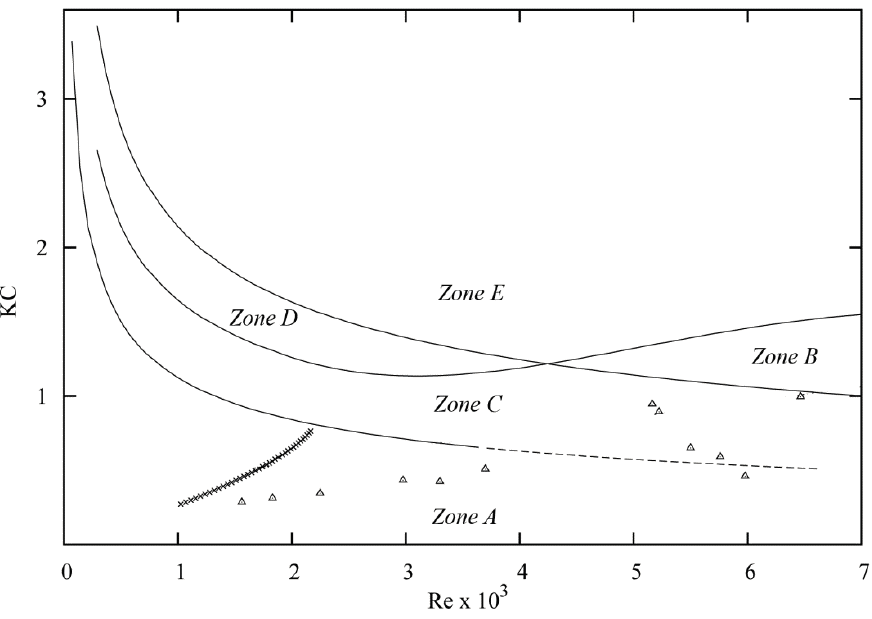
Figure 2. Scheme of viscous-fluid oscillatory-flow regimes in terms of KC and Re : (××) waves selected for a preliminary evaluation of the quantities defined in Equations (10), (11), (14) and (15); ( ∆∆ ) parameters of the experimental waves